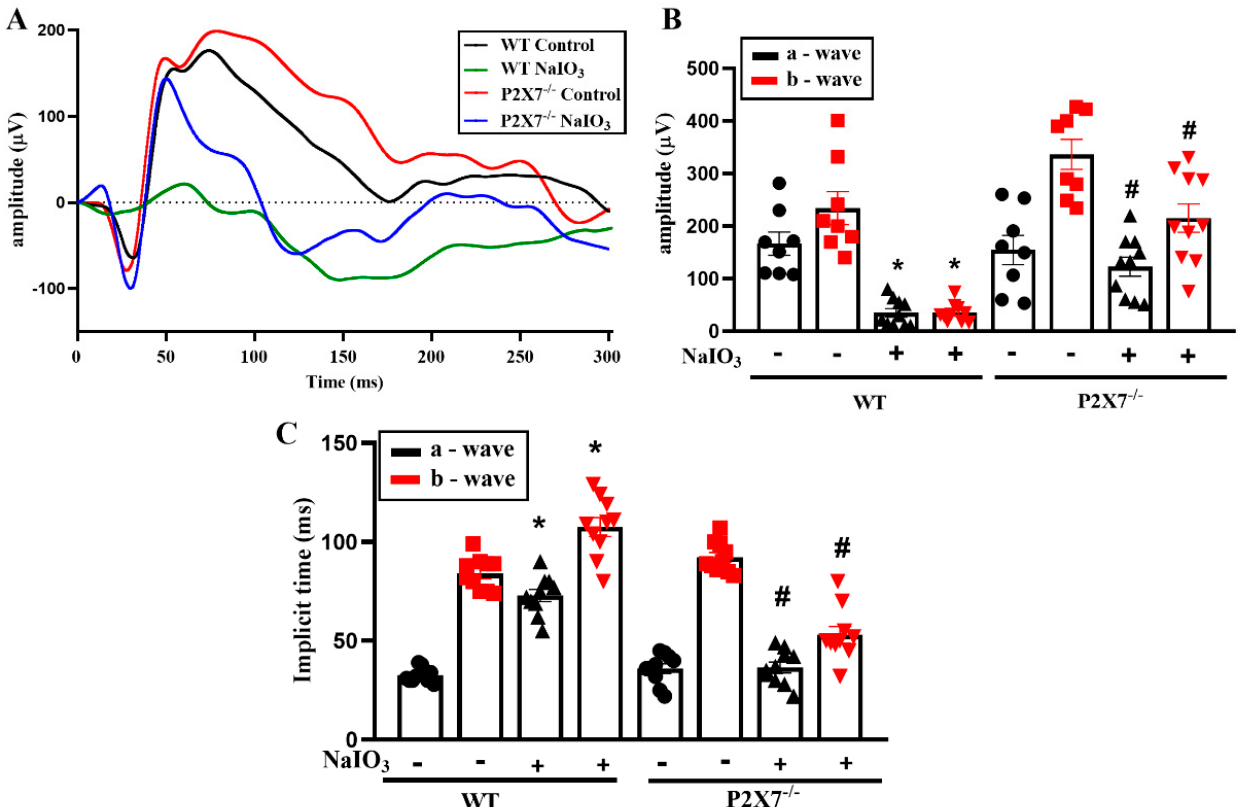
Figure 1. P2X7 − / − exerted protection against NaIO 3 -induced photoreceptor injury. ( A ) Representative scotopic ERG responses from WT and P2X7 − / − mice with or without NaIO 3 (25 mg/kg) intraperitoneal injection. Three days after injection, ERG analysis was performed. ( B ) Quantification of the average amplitudes of a and b waves from WT control mice ( n = 8), WT NaIO 3 -treated mice ( n = 8), P2X7 − / − control mice ( n = 8) and P2X7 − / − NaIO 3 -treated mice ( n = 10). ( C ) Quantification of the implicit time of a and b waves from the 4 groups of mice. The data were presented as the mean ± SEM. * p < 0.05 compared with the WT control group, # p < 0.05 compared with the WT control group treated with NaIO 3 .